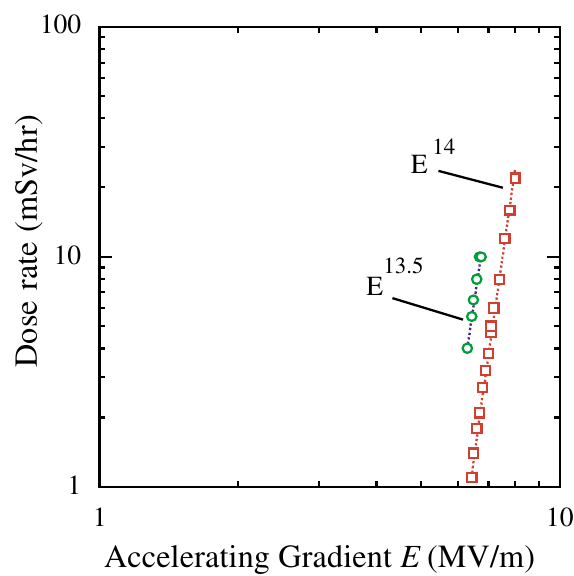
FIG. 28. (Color) Radiation levels near the ISIS linac